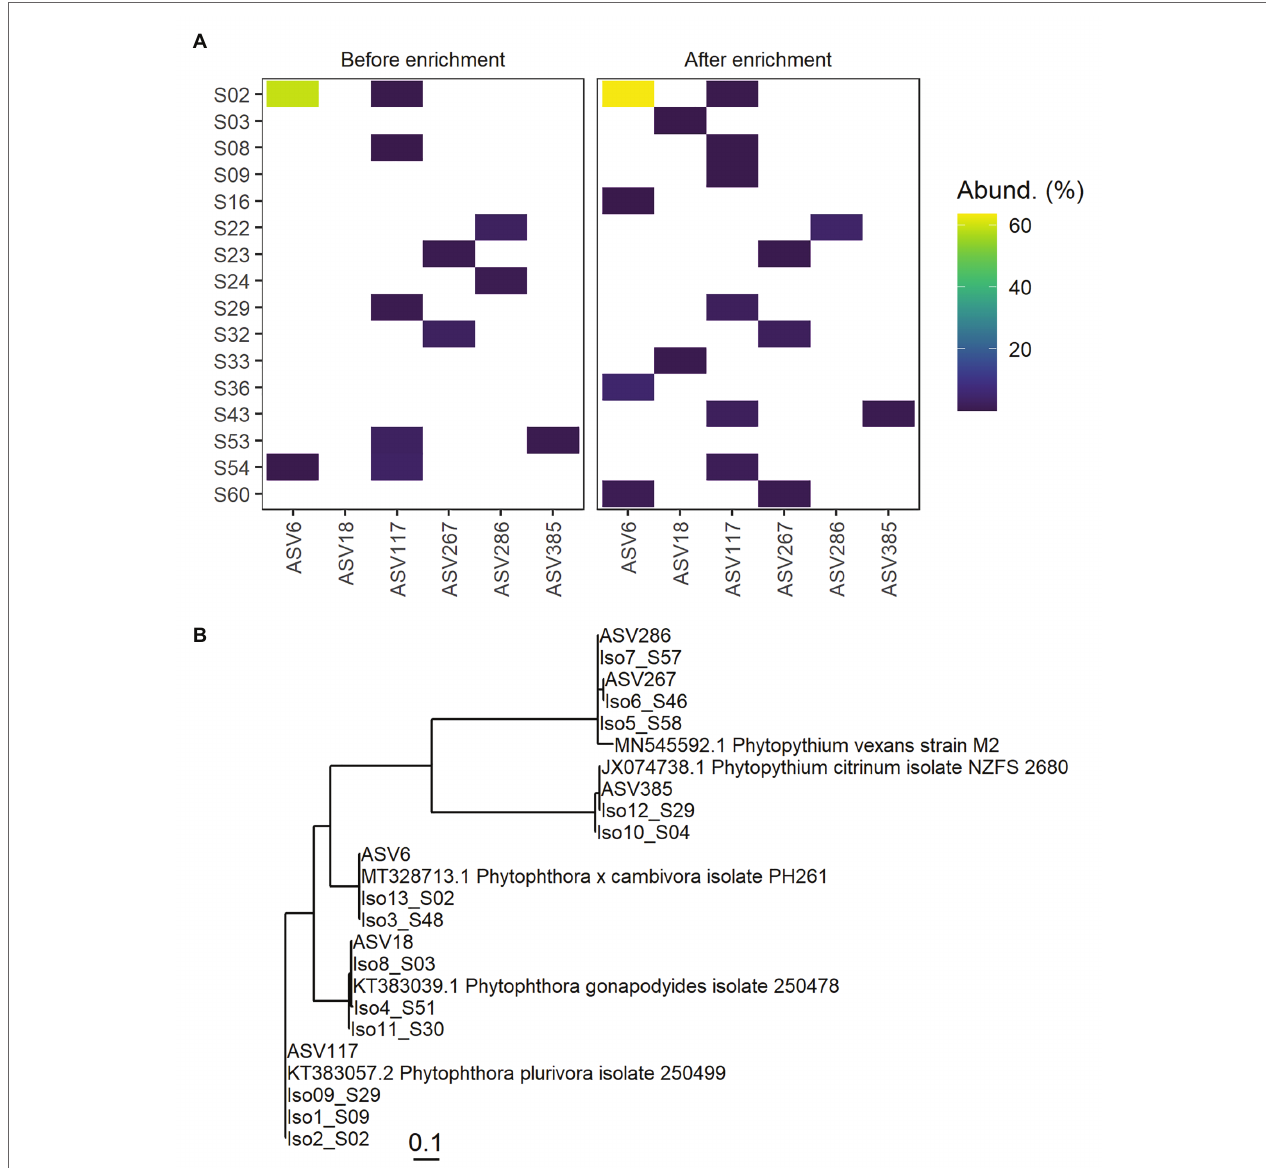
FIGURE 4 | Detection of ASVs corresponding to oomycetes isolated from rhizospheric soil samples. In (A) , the left panel shows ASV detection by metabarcoding before enrichment, the right panel after enrichment. ASVs are given on the x -axis and soil samples on the y -axis. The relative abundance of ASVs in percent of the whole soil sample is indicated on a continuous color scale, no color was assigned if the abundance was 0%. (B) shows a phylogenetic tree based on ITS-sequences of isolates, corresponding ASVs, and publicly available sequences for identified strains. Represented in a Neighbor Joining tree fitted with a General time reversible model with discrete Gamma distribution and evolutionarily invariable sites (GTR + G + I). The tree’s scale (substitutions per site) is indicated on the